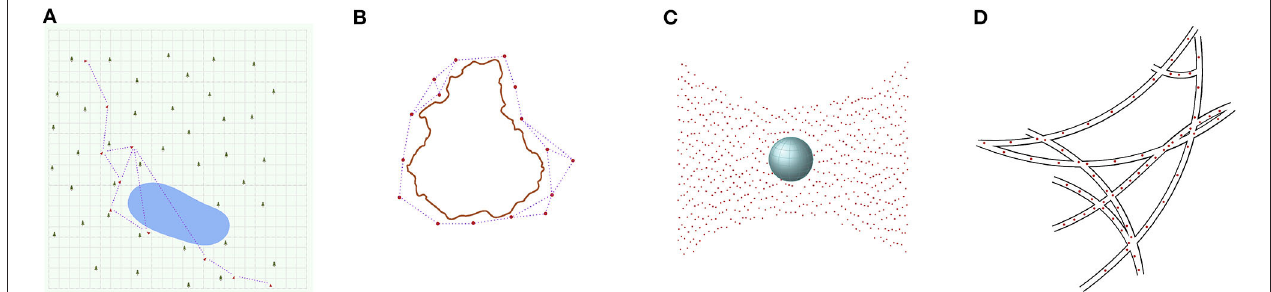
Frontiers in Robotics and AI |